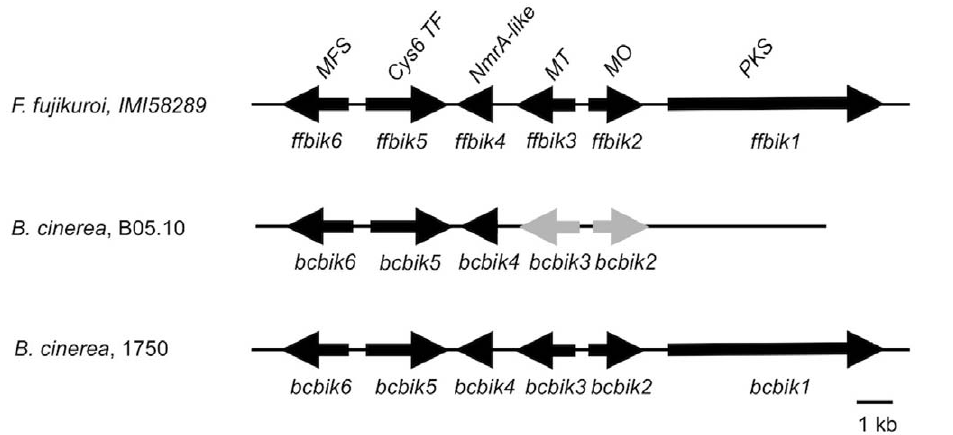
Figure 1. Schematic view of the bikaverin gene clusters in F.fujikuroi [ 14 ] , and in gray (B05.10) and pink (1750) B.cinerea strains. Complete clusters include a PKS-encoding gene ( bik1 ), a putative FAD-dependent monooxygenase ( bik2 ), an O-methyltransferase ( bik 3), a putative